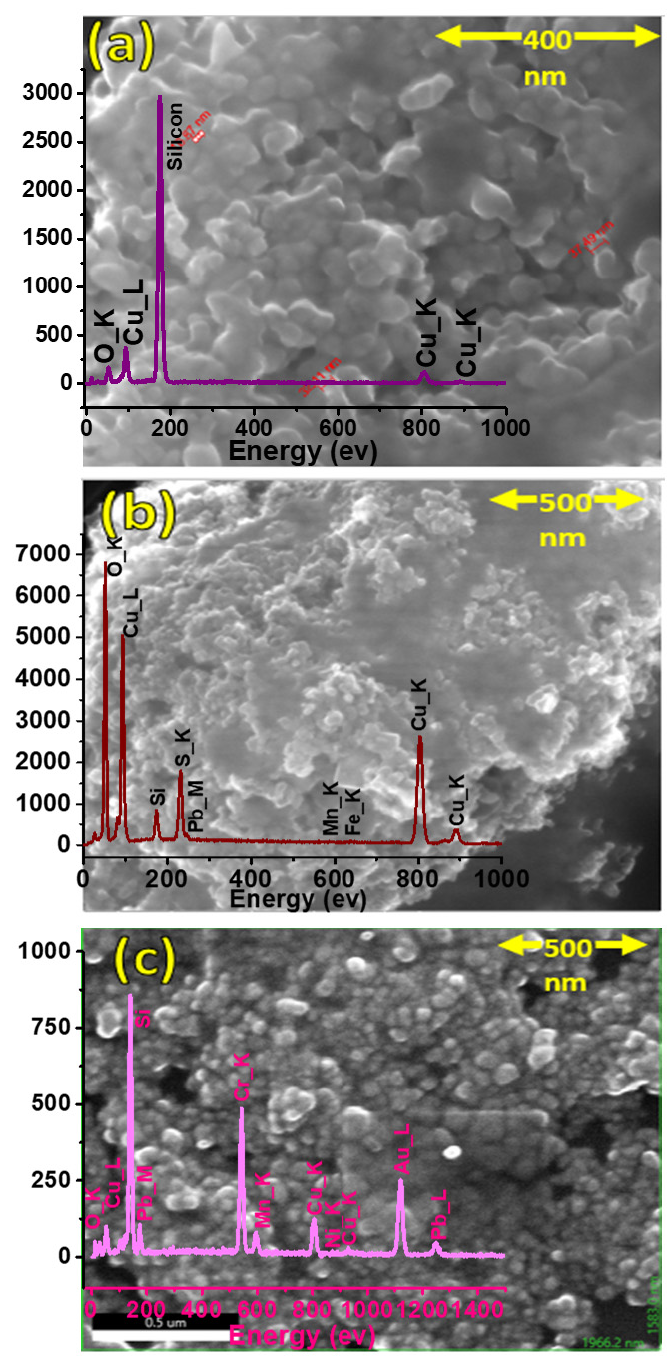
Figure 2. FESEM images of ( a ) synthesized citrate-capped CuO NPs. The inset shows the EDAX parameters of the nanoparticles. ( b ) Extracted and citrate-capped CuO from Peru mine stone sample. The inset shows the EDAX parameters of the nanoparticles. ( c ) Extracted and citrate-capped CuO from the Bhopal mine stone sample. The inset shows the EDAX parameters of the nanoparticles.